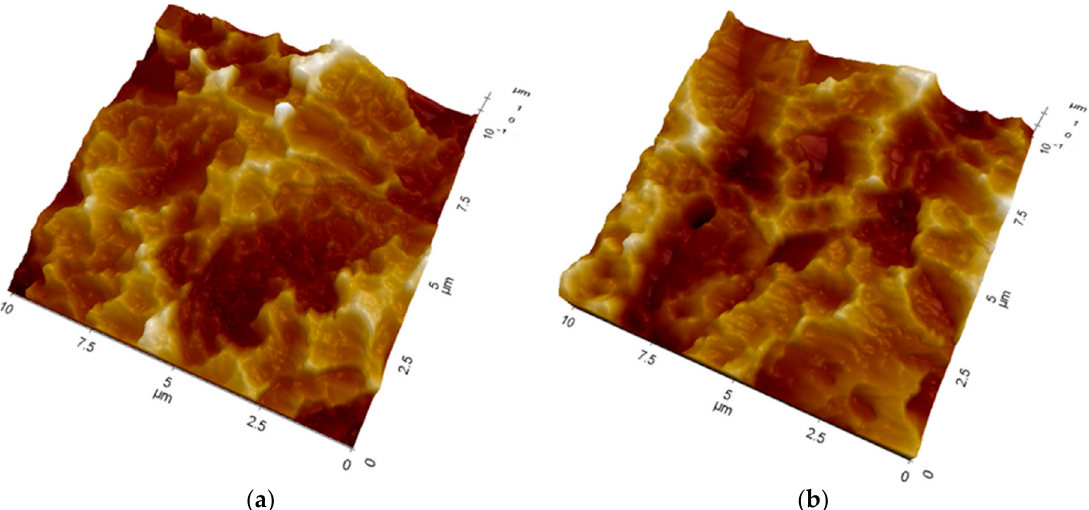
Figure 2. 10 × 10 micrometer images obtained by non-contact AFM analysis of control ( a ) and collagen coated ( b ) Ti disks subjected to the same treatment as the tested implants.